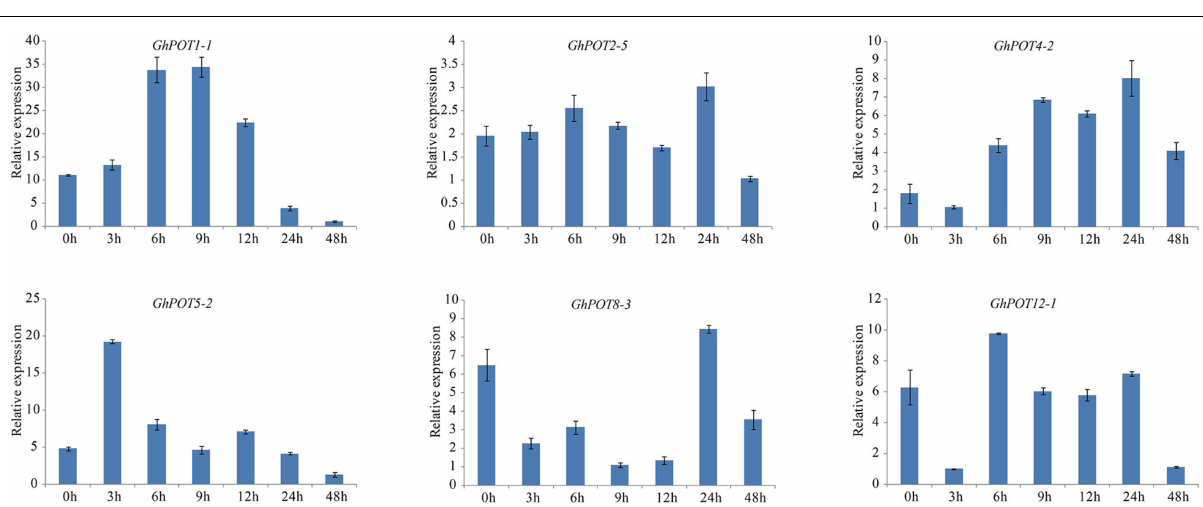
FIGURE 9 | Expressions of GhPOT genes in response to dehydration stress (18% PEG6000). The expressions of GhPOT genes were determined by qRT-PCR using the total RNA isolated from TM-1 leaves at different time points (0, 3, 6, 9, 12, 24 and 48 h) of salt stress. The error bars indicate the standard error (SE) of three biological